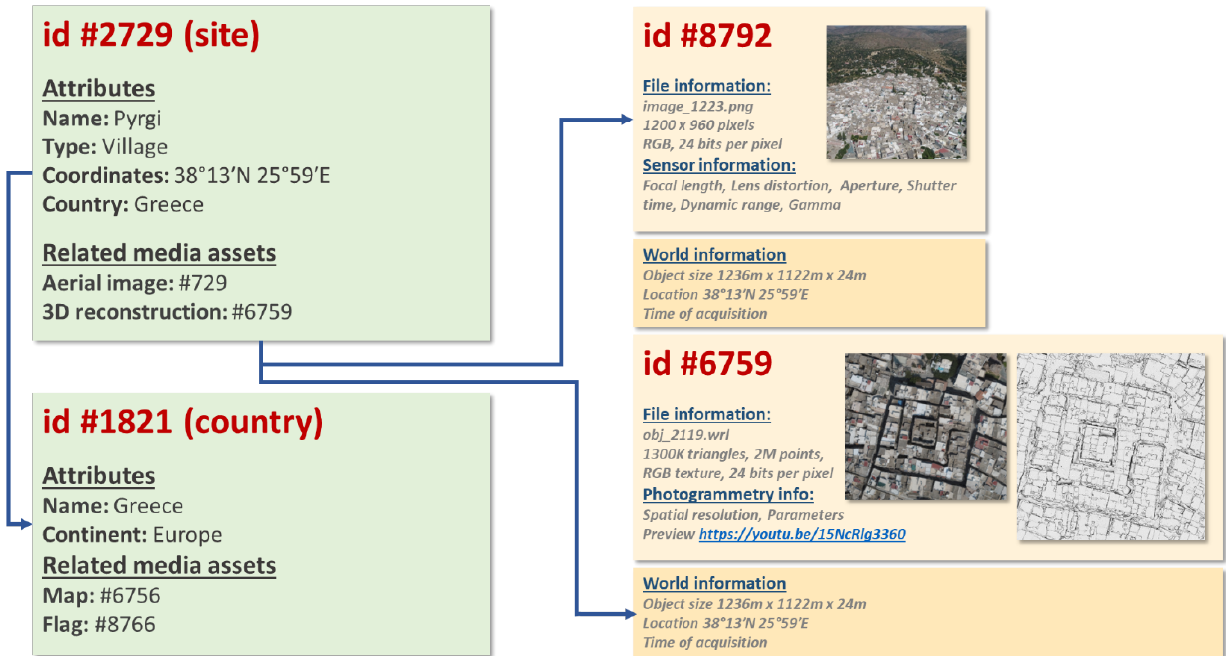
Figure 15. Authoring location-based narrative in MOP.